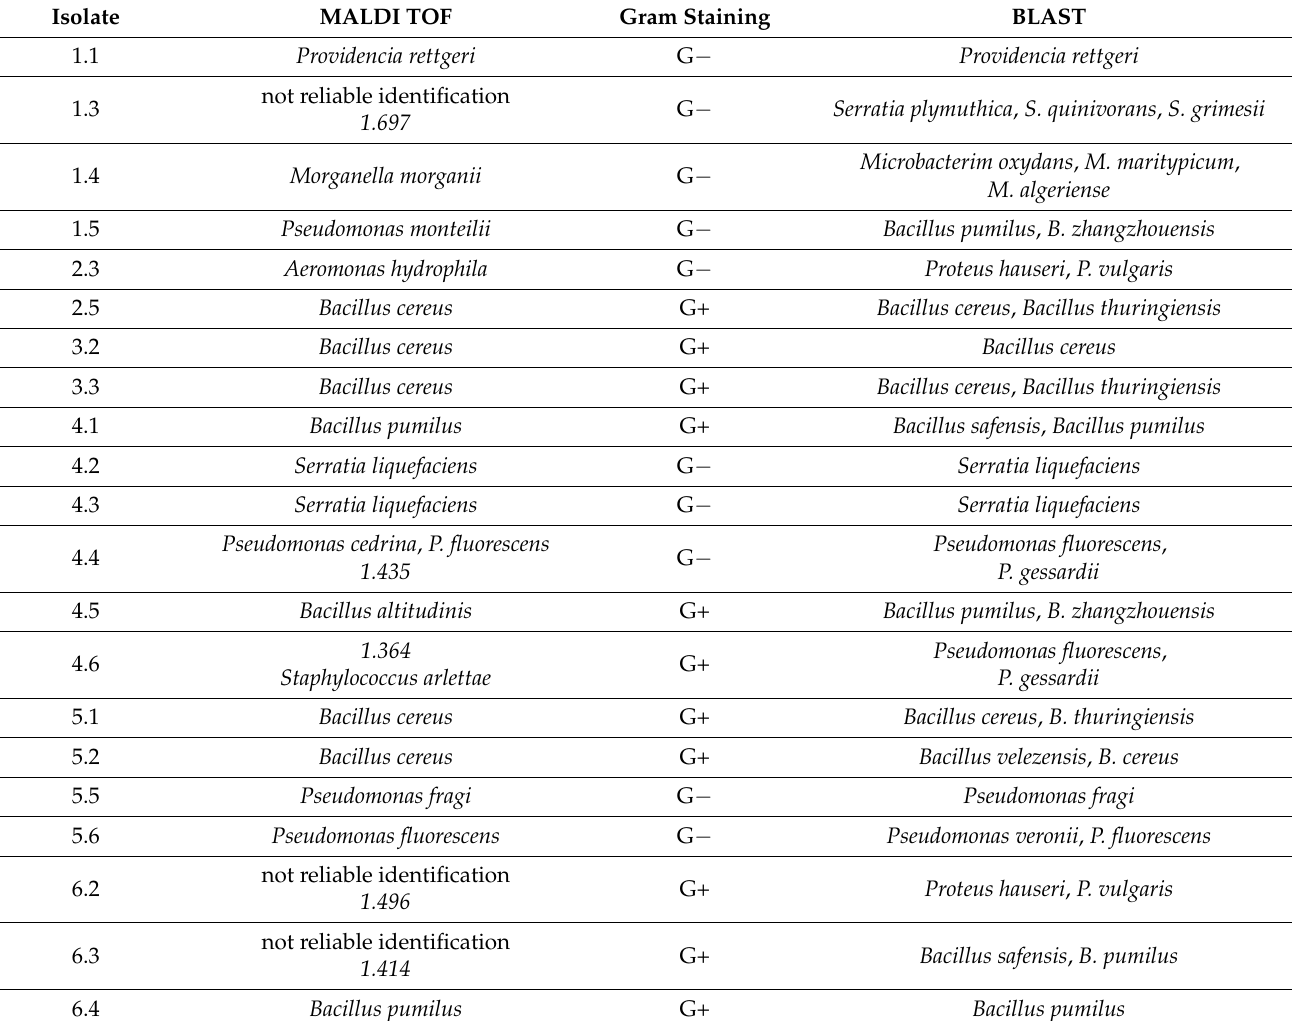
Table 3. Comparison of identification: results of Gram staining, MALDI TOF mass spectrometry, and BLAST analysis of 16s rRNA